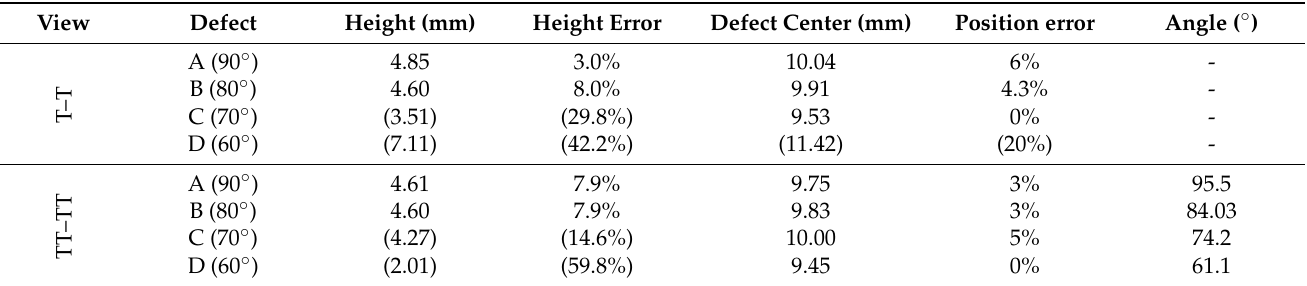
Table 5. Defects height, center position, and related errors for both T–T and TT–TT views using the TFM algorithm. Angle of the defect determined using the principal axis of the TT–TT view.